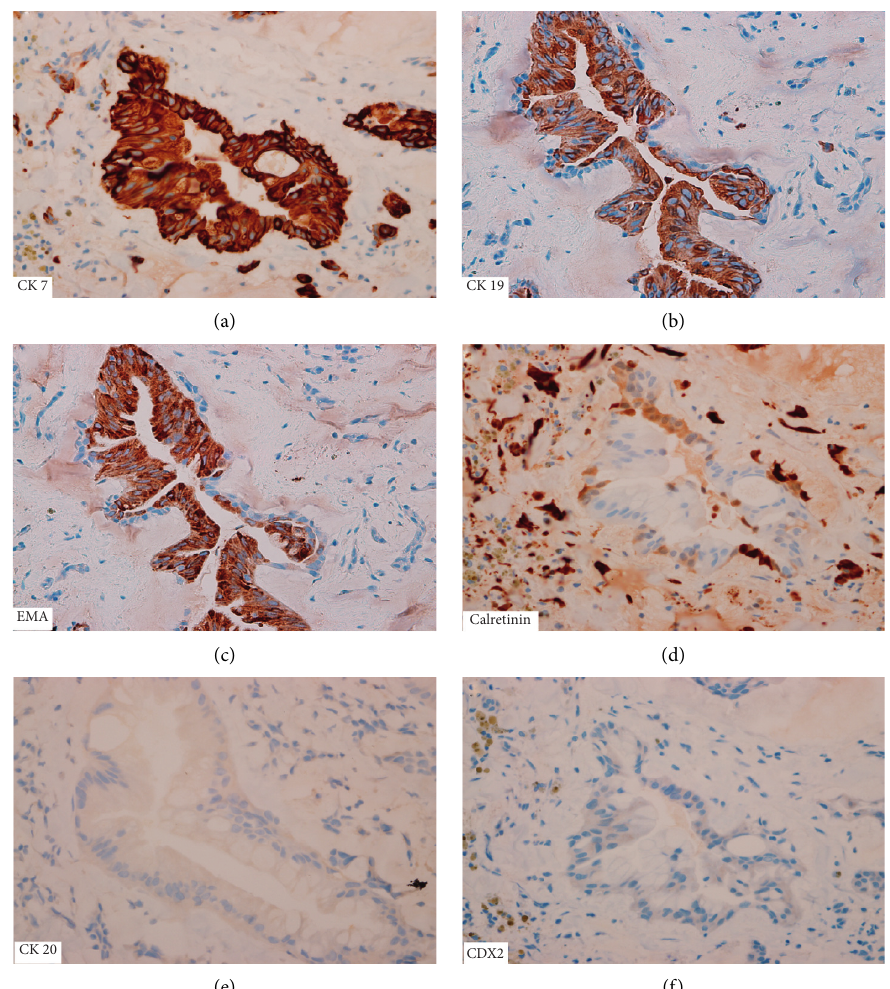
Figure 5: Immunohistochemical profile of the glandular epithelium showing strong immune reactivity to CK7 (a), CK19 (b), and EMA (c), while faintly and focally reactive for calretinin (d). There was no reactivity for CK20 (e) and CDX2 (f) (original magnification ×